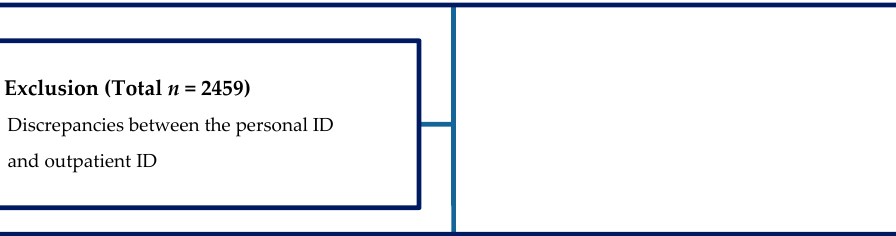
No. of patients who used overall medical services in 2016 KHPS ( n = 17,424)